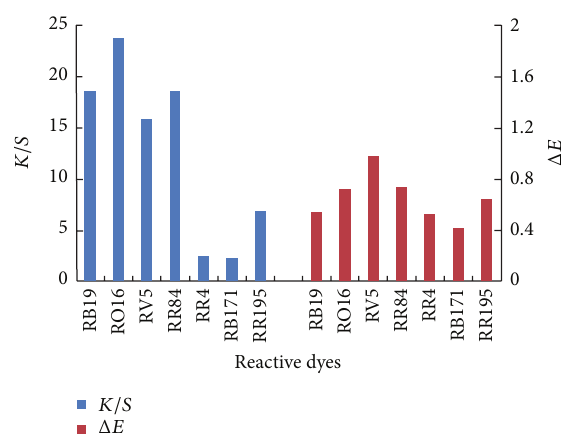
Figure 9: FTIR of amidoximated acrylic fibres, RR84, and amidox- imated acrylic fabrics dyed with RR84; dyeing conditions: shade 2% owf, liquor ratio 40 :1, pH 2.5, at 100 ∘ C for 60min.